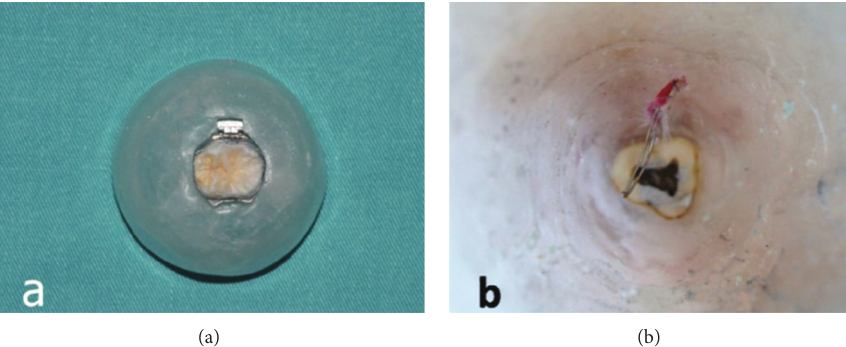
Figure1:(a)Thetopviewoftheacrylicplatformandthemolartoothwithorthodonticbandplacedinthemiddle.(b)Thebottomimageofthe acrylic platform. Note that the inside of the platform was emptied and the crown of the molar tooth was inserted on top of it. The root portion was removed and the cap of the pulp can be seen with conductor gel injected into the cavity providing the transfer of outside temperature changes to the thermocouple wire imitating the pulpal tissue conductibility. The cable was inserted through a hole on the platform.